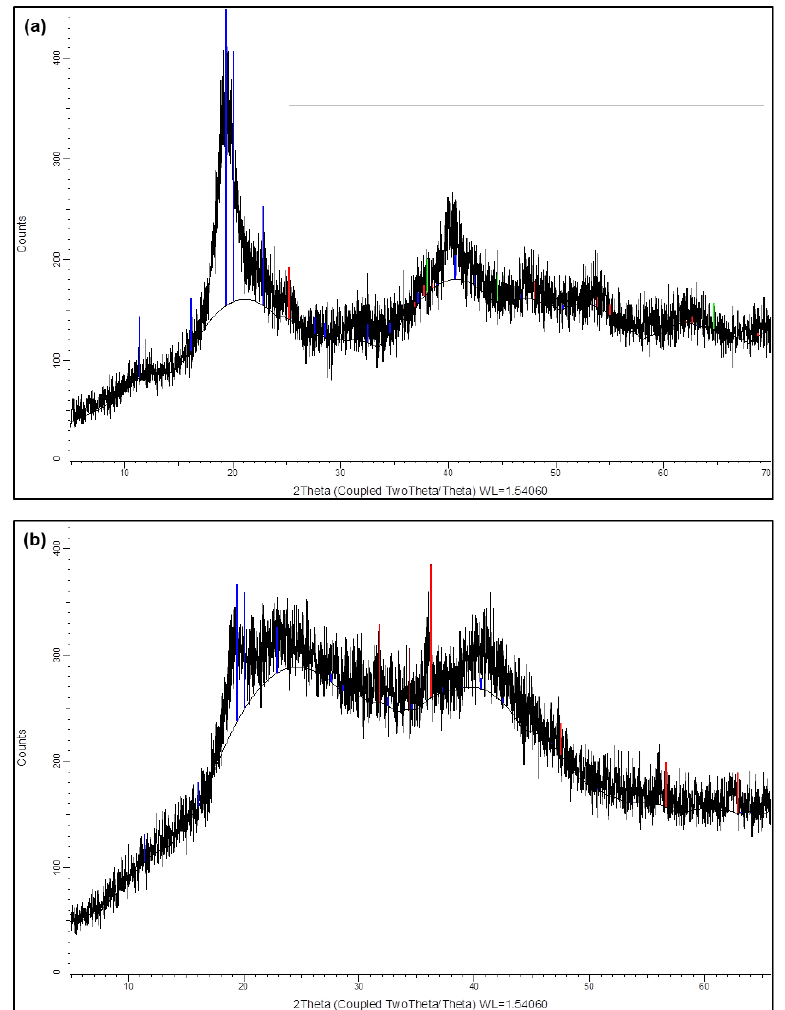
Figure 9. X-ray diffraction patterns from: ( a ) PVA/GA/Ag-TiO 2 -NPs and ( b ) PVA/GA/ZnO-NPs. Figure 9. X-ray di ff raction patterns from: ( a ) PVA / GA / Ag-TiO